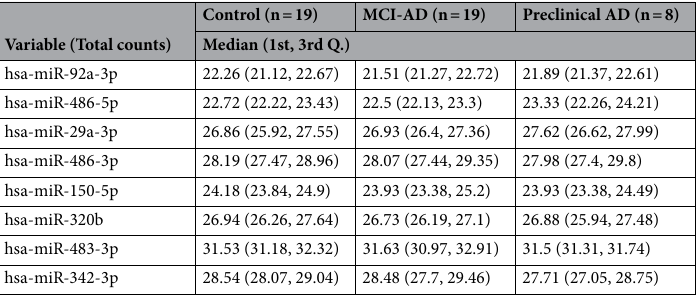
Table 2. Median levels of miRNAs in plasma from participants’